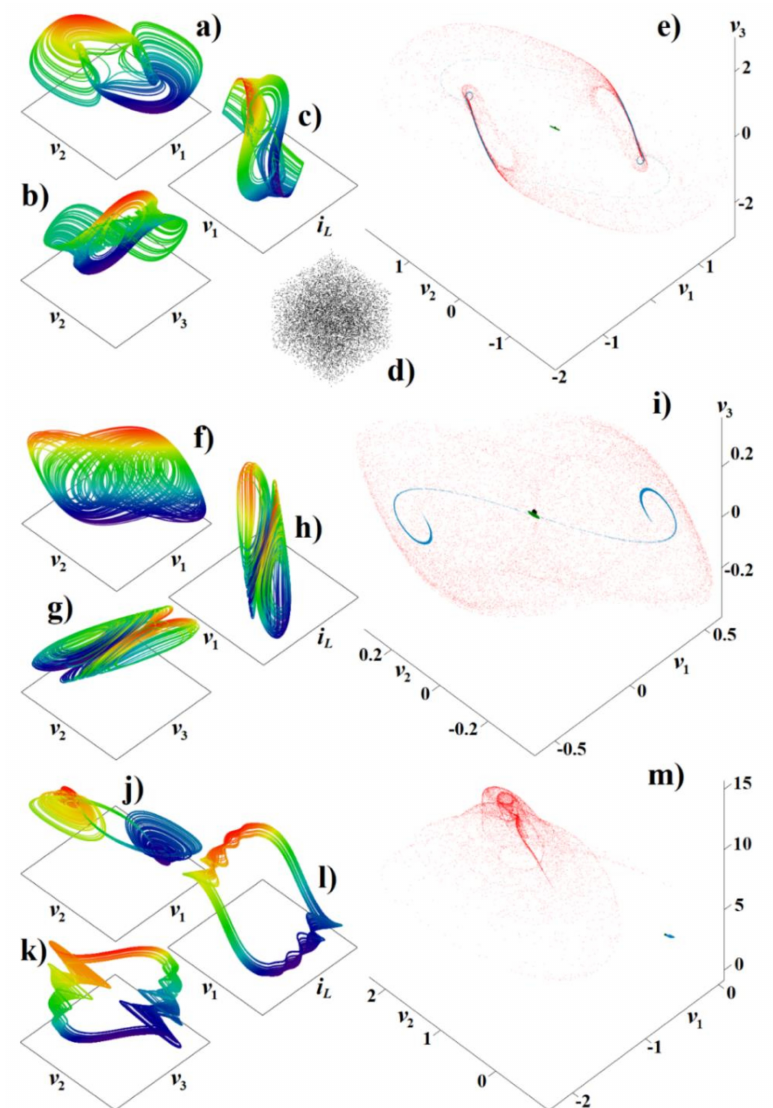
Figure 3. Cascoded resonant amplifier considered as fourth order dynamical system, parameter = case b = 9.02 S and b = 3.76 S, generated strange attractor projected in: ( a ) subspace v 1 - v 2 - v 3